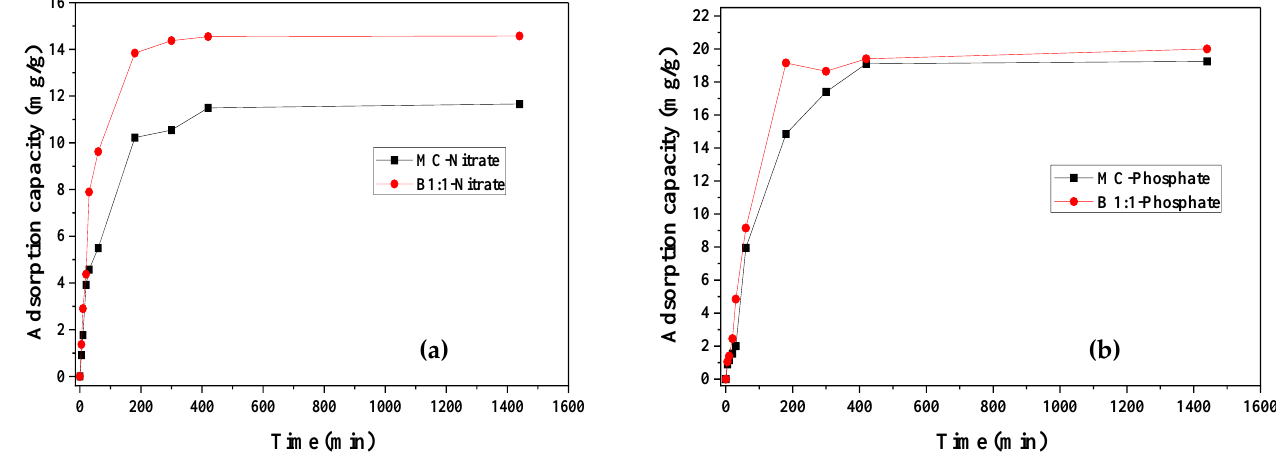
Figure 7. Adsorption kinetics for ( a ) nitrate and ( b ) phosphate. Table 4. Kinetic Model Adjustment Parameters.